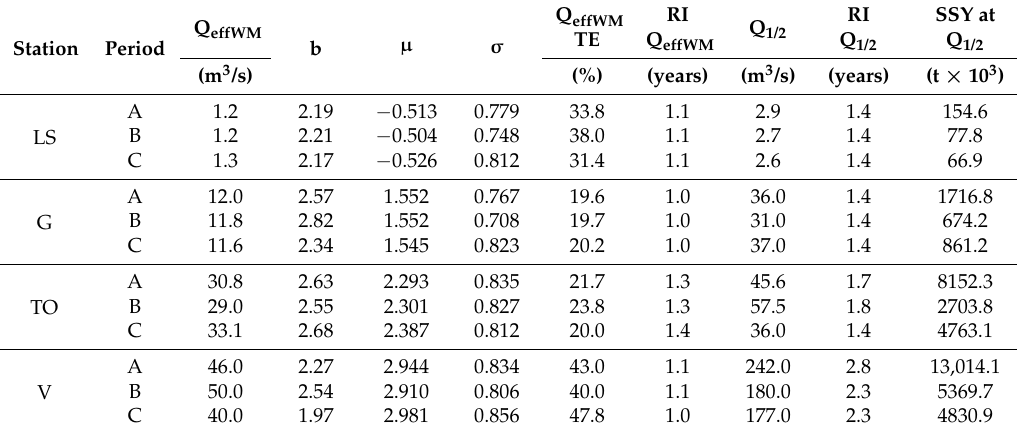
Table 4. Effective discharges and half-load discharge for suspended sediment transport in the